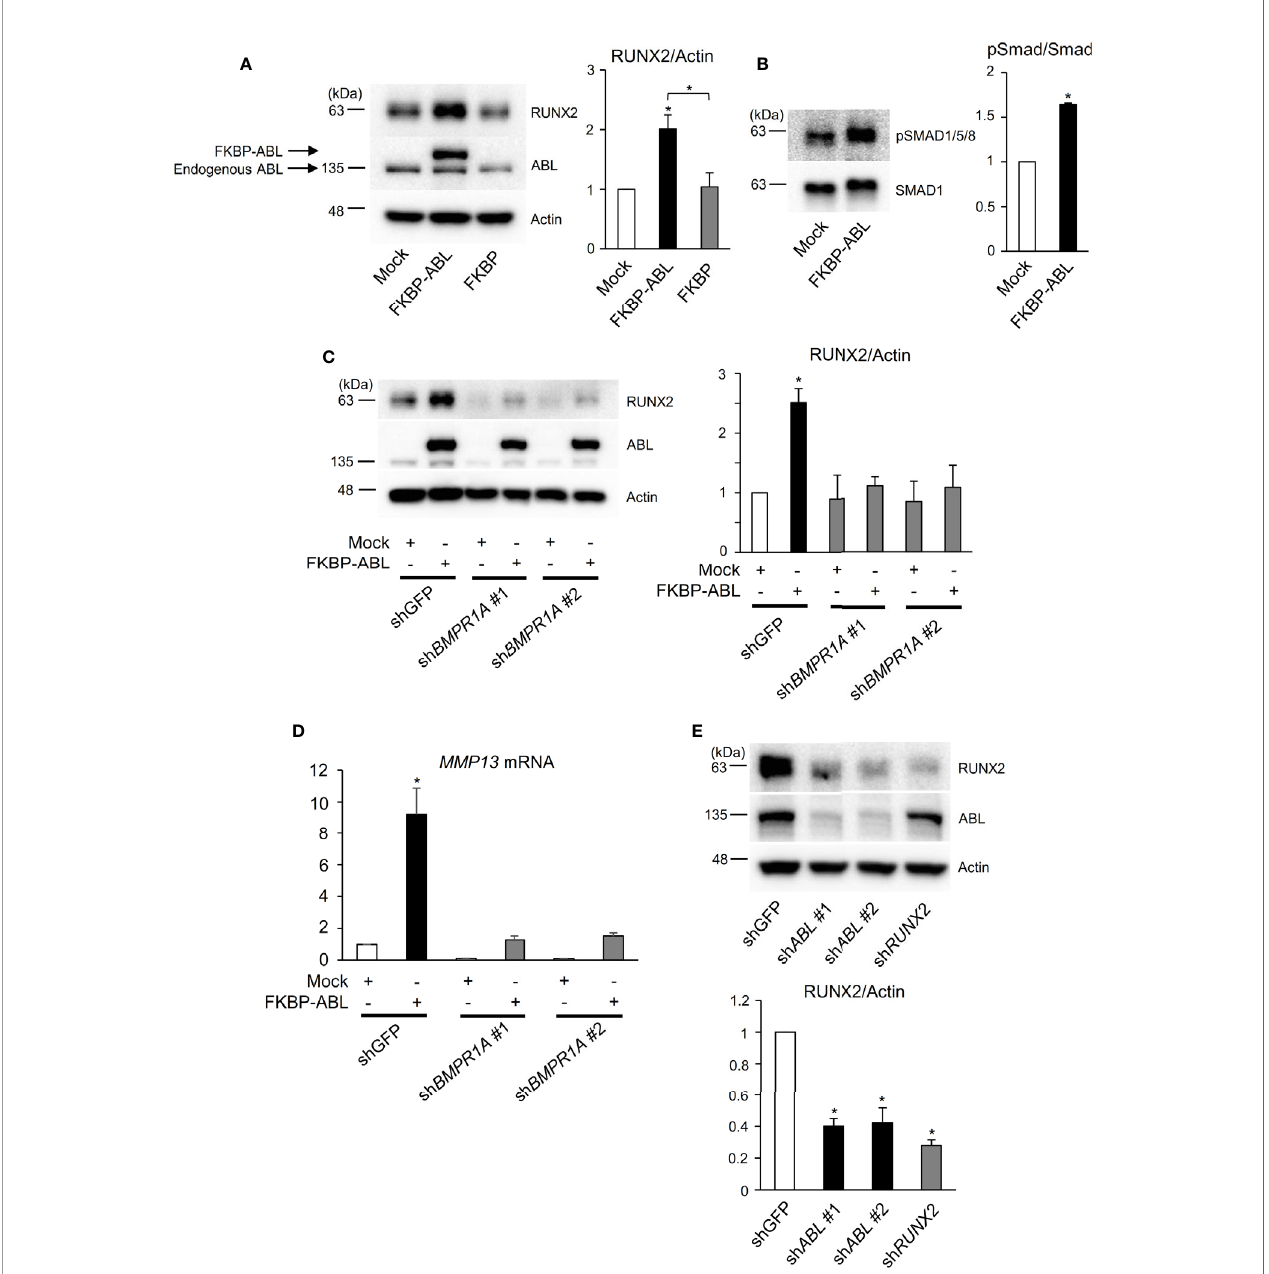
FIGURE 4 | ABL regulates RUNX2 expression through control of the BMP-SMAD pathway. (A, B) Saos-2 cells were infected with an empty vector control or an FKBP-ABL- or FKBP-expressing retroviral vector. Whole cell lysates were probed with the indicated antibodies for Western blot analysis. (C) Saos-2 cells were infected with an empty vector control or an FKBP-ABL-expressing retroviral vector in the presence of shGFP or sh BMPR1A . Whole cell lysates were probed with the indicated antibodies for Western blot analysis. (D) Quantitative PCR analysis of MMP13 mRNA expression in cells in (C) . n = 3. (E) MDA-MB231 cells were infected with an shGFP-, sh ABL- or sh RUNX2 -expressing vector. Whole cell lysates were probed with the indicated antibodies for Western blot analysis. P values were determined by ANOVA with Tukey – Kramer ’ s post hoc test. Data are presented as means ± SEM. *P <